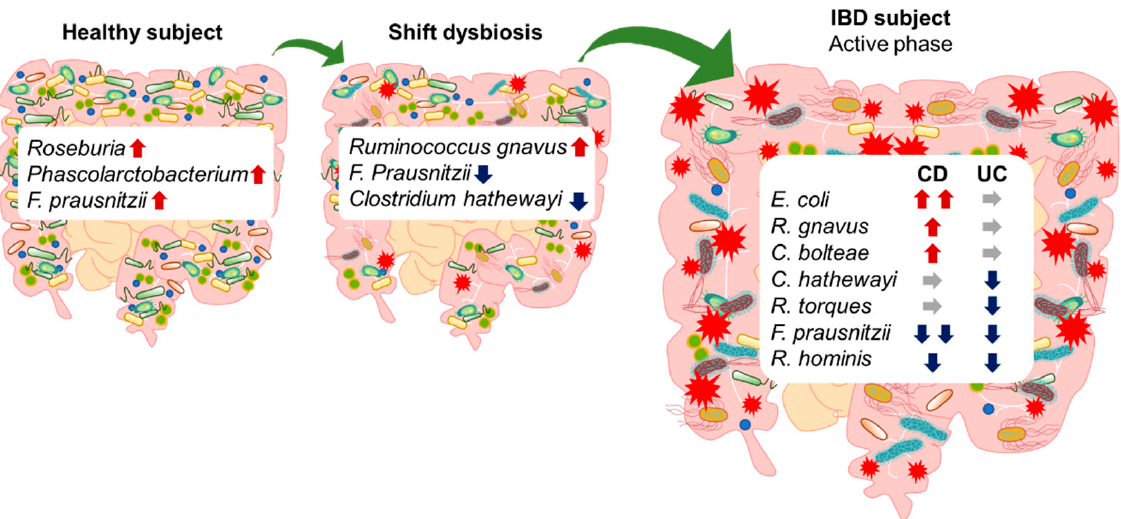
Figure 1. The gut microbiota is altered in IBD patients compared to healthy subjects. Up-arrows indicate an increase, down-arrows indicate a decrease, and horizon-arrows indicate no changes.